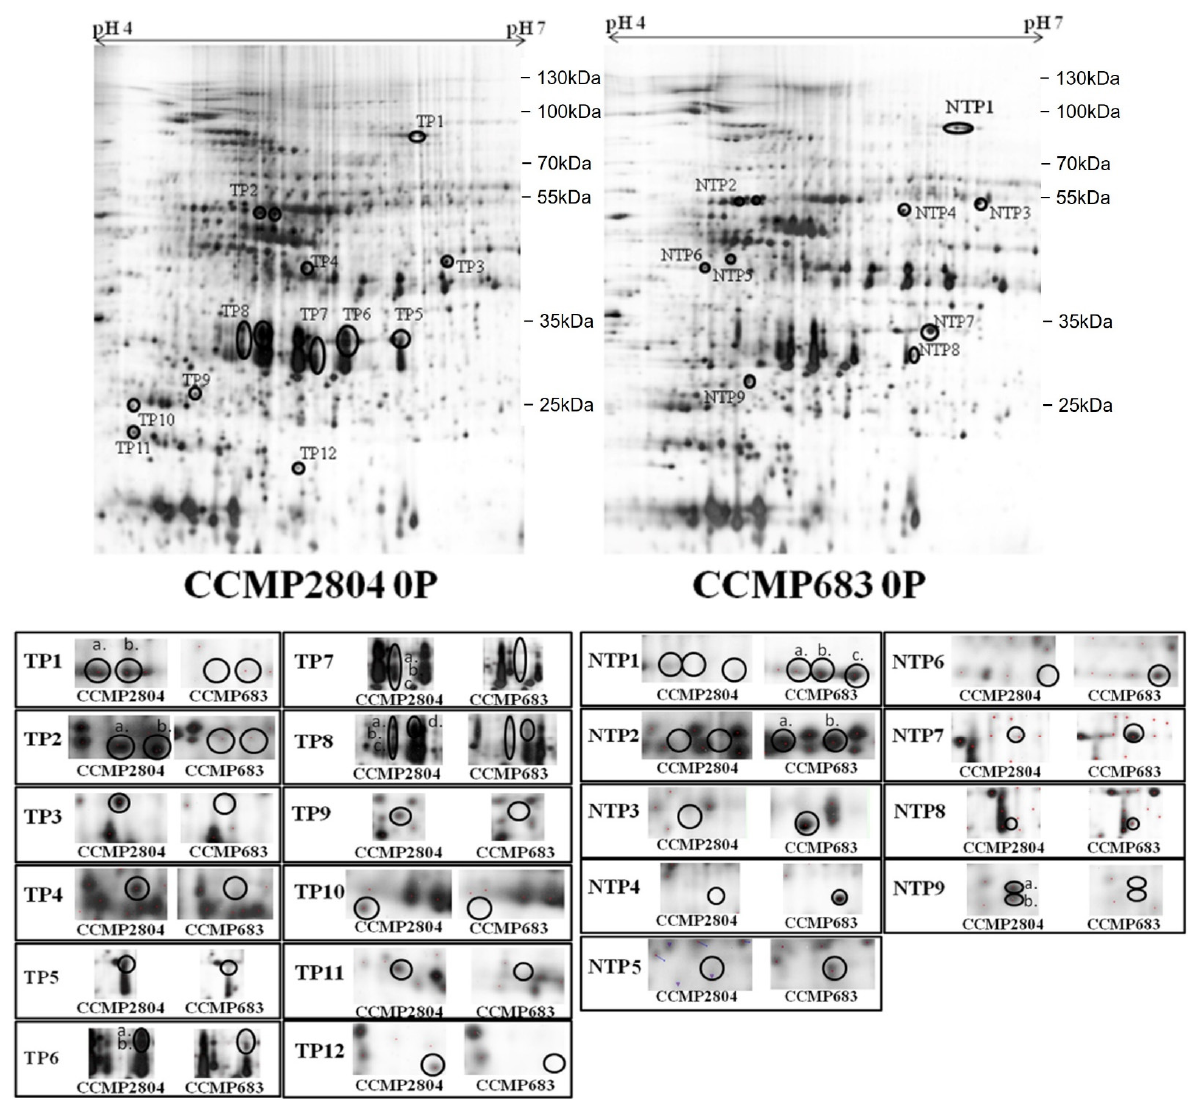
Figure 2. Representative 2-DE profiles of 100 µ g protein extracted from CCMP2804 and CCMP683 under phosphate depletion (0P) separated over a pH range of 4–7 and then by 10% SDS-PAGE. Protein visualization was performed with silver stain. The circled spots with initials “TP” and “NTP” were upregulated in the toxic strain and non-toxic strain respectively when compared with each other. A side-by-side comparison of each pair of enlarged differential protein spots was